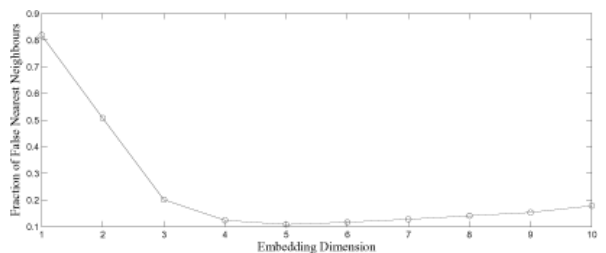
Fig. 4. Plot of fraction of false nearest neighbors against embedding dimension obtained from the detrended TEC data measured from